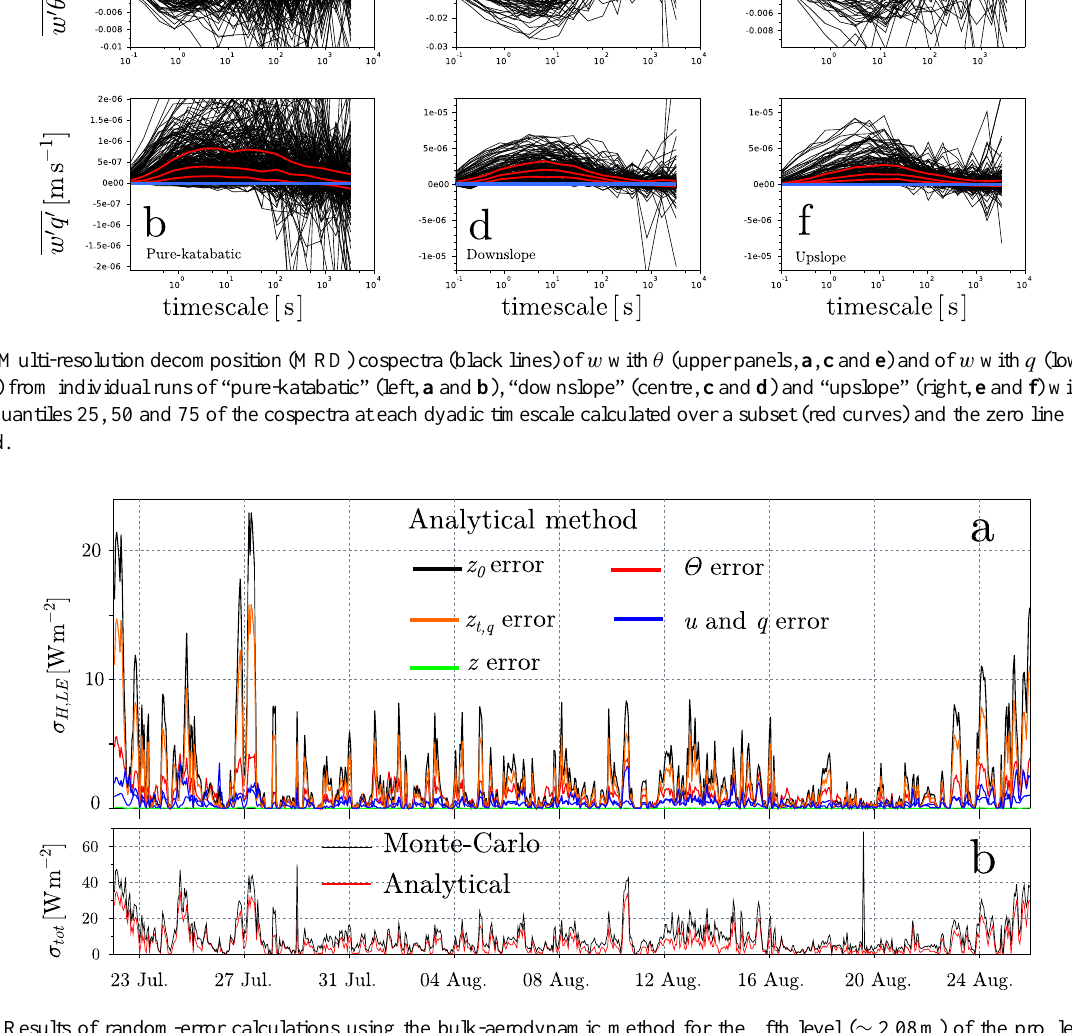
Figure 6. Results of random-error calculations using the bulk-aerodynamic method for the fifth level ( ∼ 2 . 08m) of the profile mast. (a) Change in individual random-error terms during the campaign estimated with the analytical method: z 0 error (black), z t,q error (orange), θ error (red), u and q error (blue), and z error (green). (b) Change in the random error in net turbulent flux during the campaign, calculated with the Monte Carlo (black) and analytical (red)